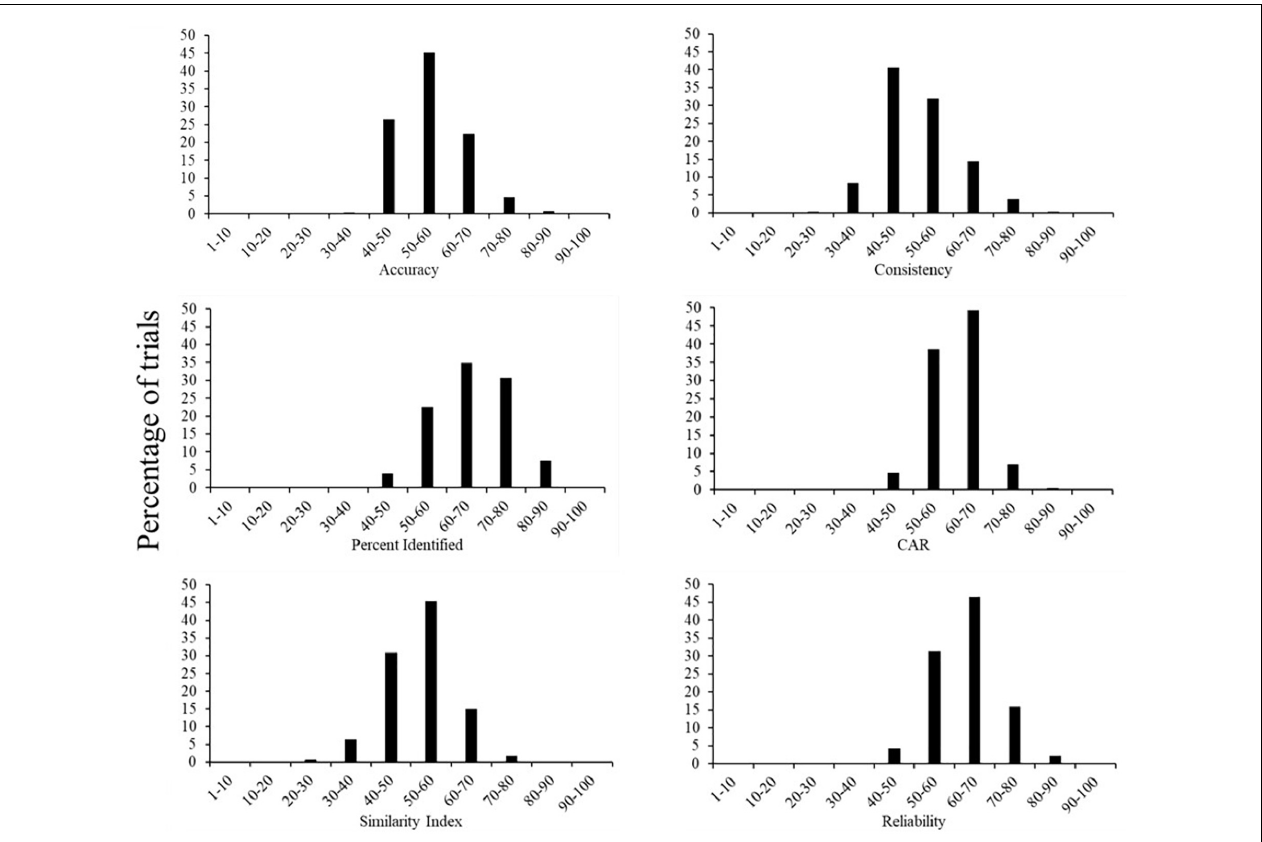
FIGURE 2 | Quality of data collected by volunteers in the 513 validation trials performed during the 9-year research project STE (2007–2015). Distribution of data is divided in classes depending on the mean score percentage that each validation trial achieved for the studied parameters. For the parameters Similarity Index and Reliability the reference score is the lower bound calculated from 95% CI of the mean values.